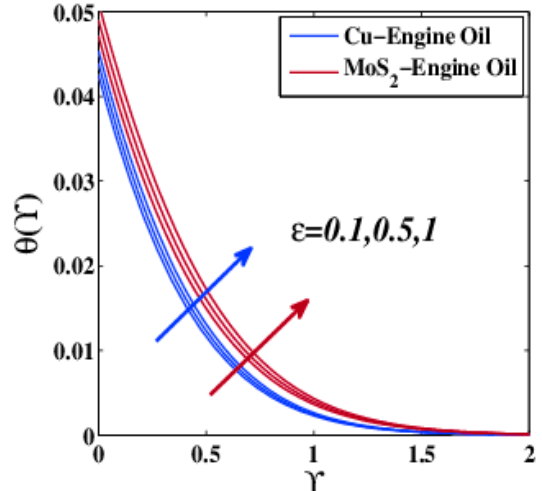
Figure 21. Temperature variation θ ( Y ) under the influence of ε .